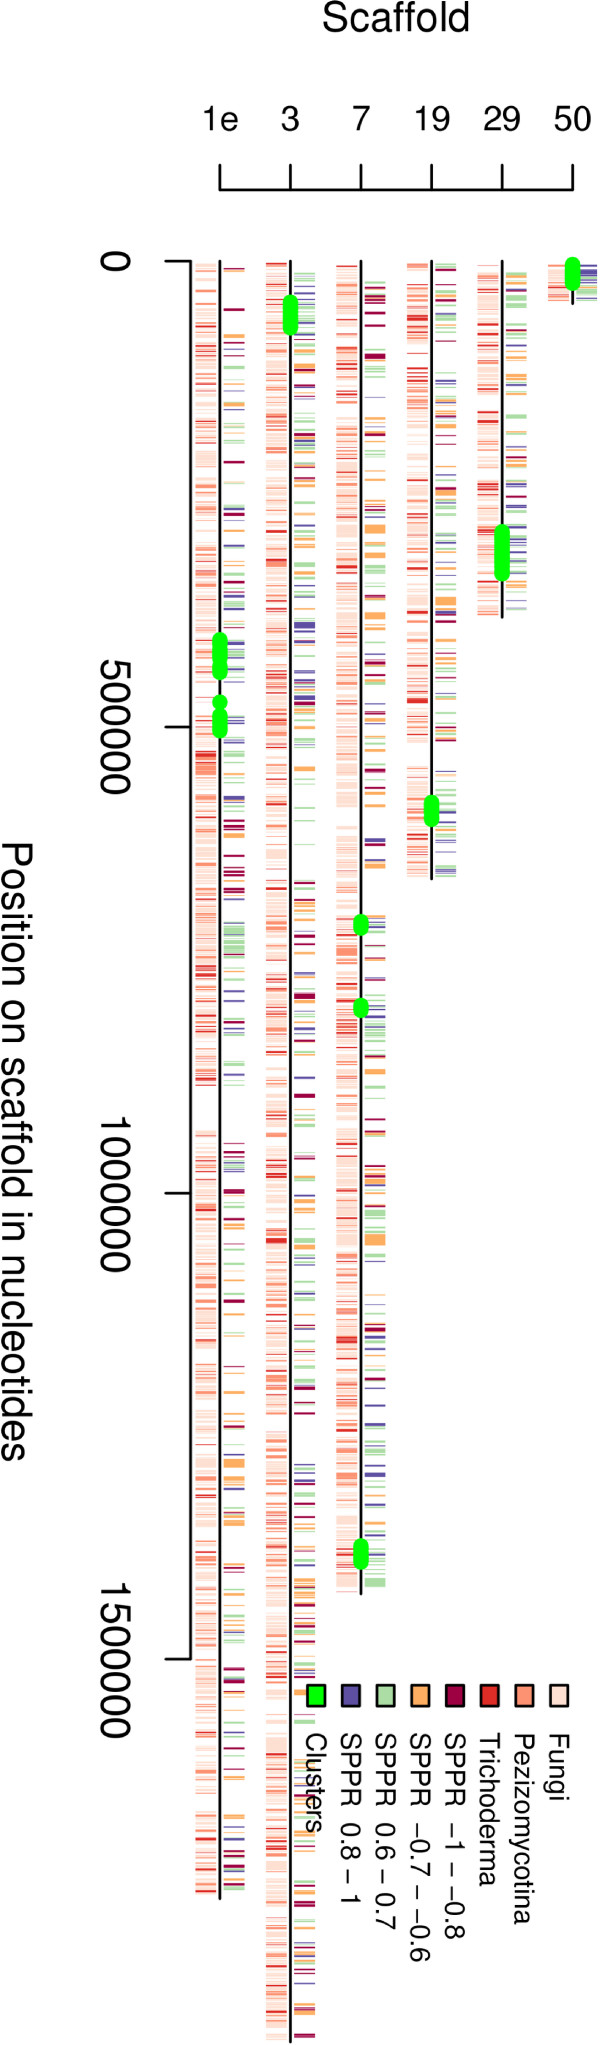
Chromosomal gene clusters with positive correlation with SPPR on scaffolds. The Y axis shows the scaffold. Only end of scaffold 1 is shown i.e. 2 - 3.75 Mb (1e). Only scaffolds with chromosomal gene clusters are shown. The × axis shows the nucleotide position on scaffold. Below each scaffold (black line) a color coding is shown for taxonomic specificity as in Figure 3. Above each scaffold a color coding is shown for gene expression correlation to specific protein production rate. Detected clusters (Additional file 1, Table S6) are highlighted in green.